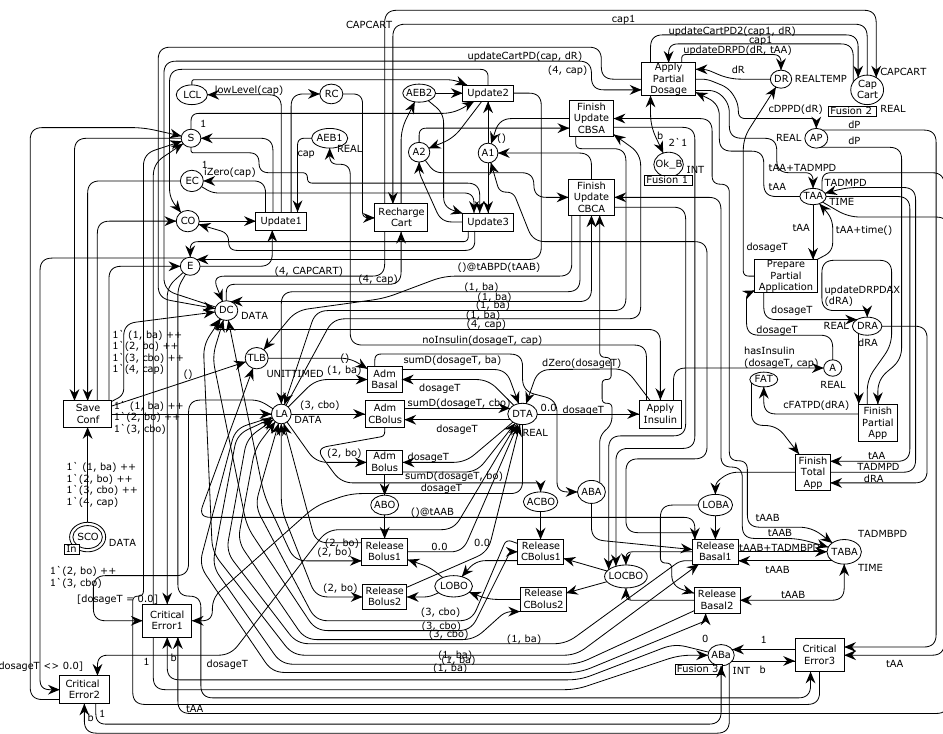
Figure 8. Standard Infusion submodule of the second system